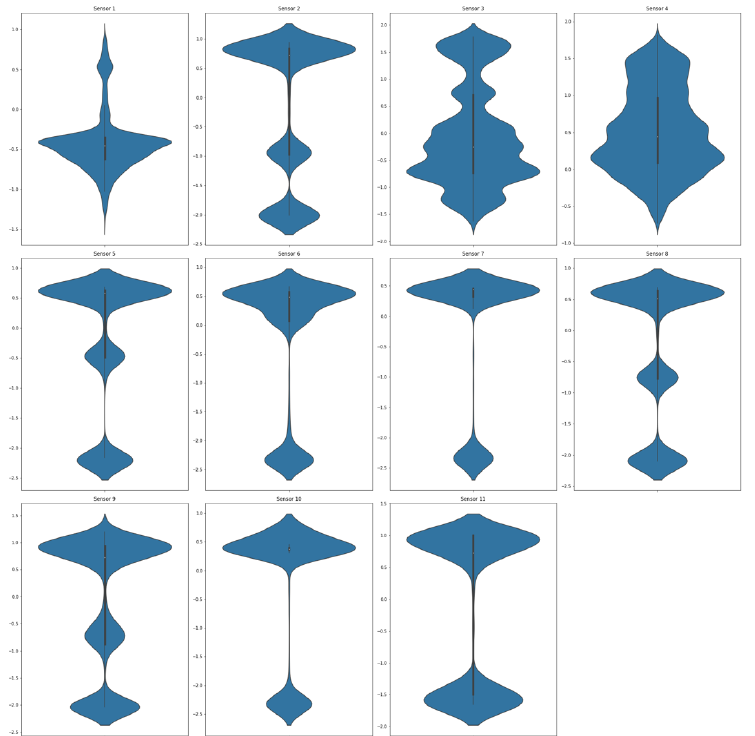
Figure 4. Violin plot of the normalized selected dataset for each of the features . The white dot in the middle represents the median value, and the thick black bar in the middle represents the interquartile range. The thin black line extending from it represents the upper (max) and lower (min) adjacent